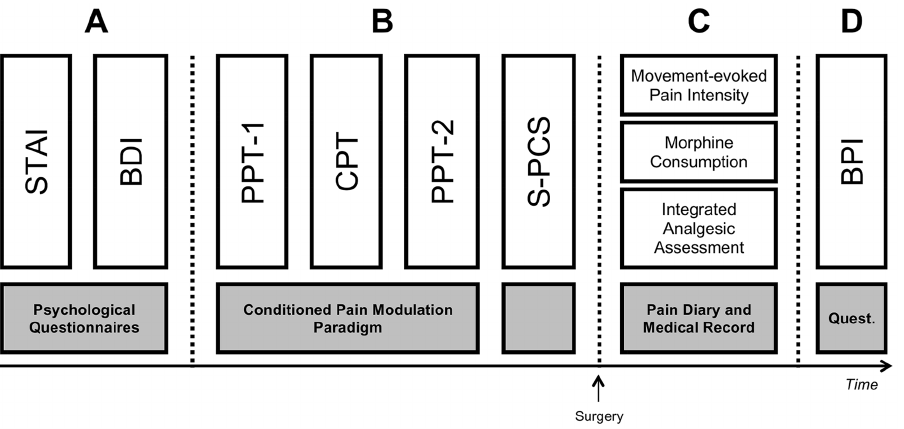
Figure 1. Schematic illustration of the study protocol. ( A ) The day before scheduled surgery patients completed the Spielberger’s State-Trait Anxiety Inventory (STAI) and Beck’s Depression Inventory (BDI); ( B ) Then patients underwent a conditioned pain modulation paradigm in which a baseline pressure pain threshold was measured at the quadriceps muscle followed by a conditioning painful stimulus induced by a cold pressor test (CPT) (i.e., hand immersion in an ice water bath for 120 seconds). After 120 seconds of hand immersion (or upon spontaneous hand removal) the pressure pain threshold at the quadriceps muscle was reassessed. The Situational Pain Catastrophizing Scale (S-PCS) was re-administered within five minutes after cold pressor test and patients were instructed to reference the cold pressor pain while answering; ( C ) From postoperative days 2–5 pain-related outcomes were assessed, including postoperative movement-evoked pain intensity, morphine consumption, and an integrated analgesic assessment score based on the aforementioned; ( D ) Persistent postoperative pain was assessed according to responses to the Brief Pain Inventory – Short Form (BPI) at six months.